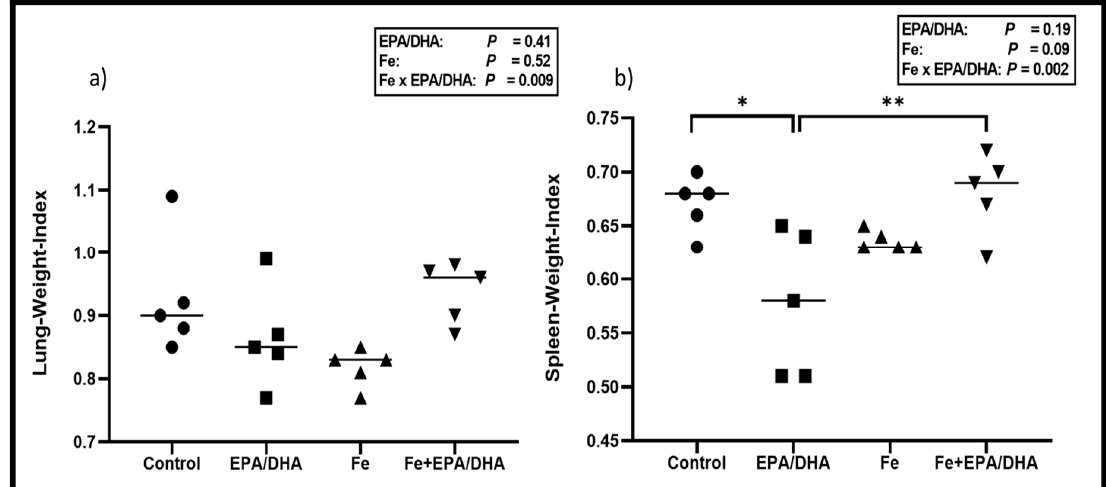
Figure 2. Mean ( a ) lung-weight-index and ( b ) spleen-weight-index after providing Mtb -infected mice